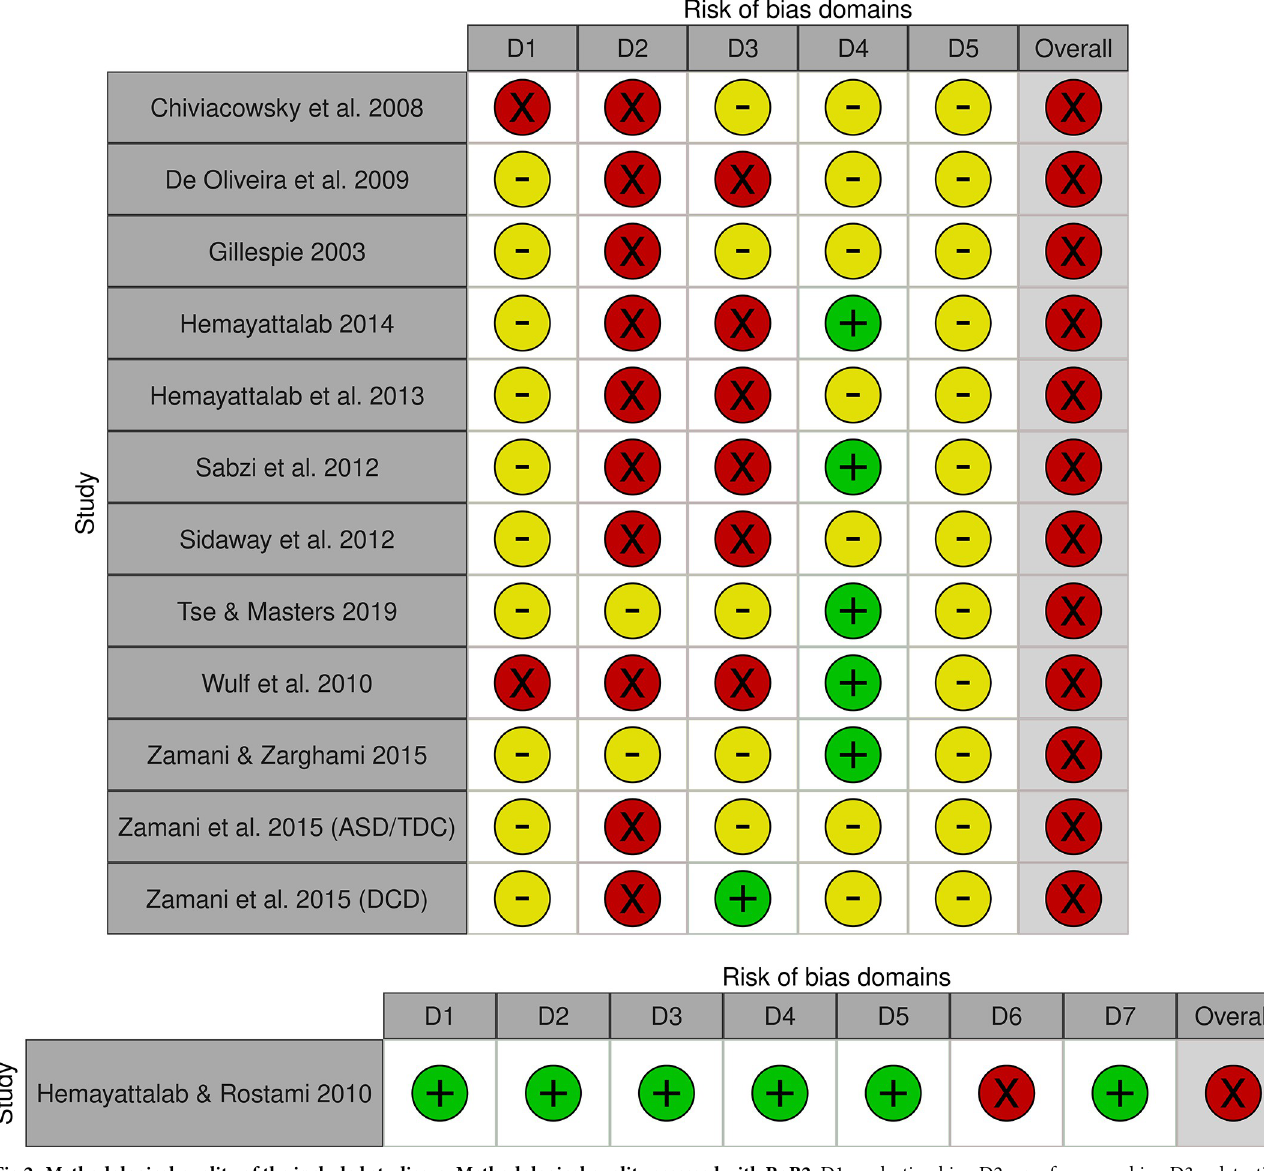
Fig 2. Methodological quality of the included studies. a. Methodological quality assessed with RoB2. D1 = selection bias; D2 = performance bias; D3 = detection bias; D4 = attrition bias; D5 = reporting bias; = low risk; = some concerns; = high risk. b. Methodological quality assessed with ROBINS-I. D1 = bias due to confounding; D2 = selection bias; D3 = classification bias, D4 = bias due to deviation from intended interventions; D5 = bias due to missing data; D6 = bias in measurement of outcomes; D7 = reporting bias; = low risk; = serious